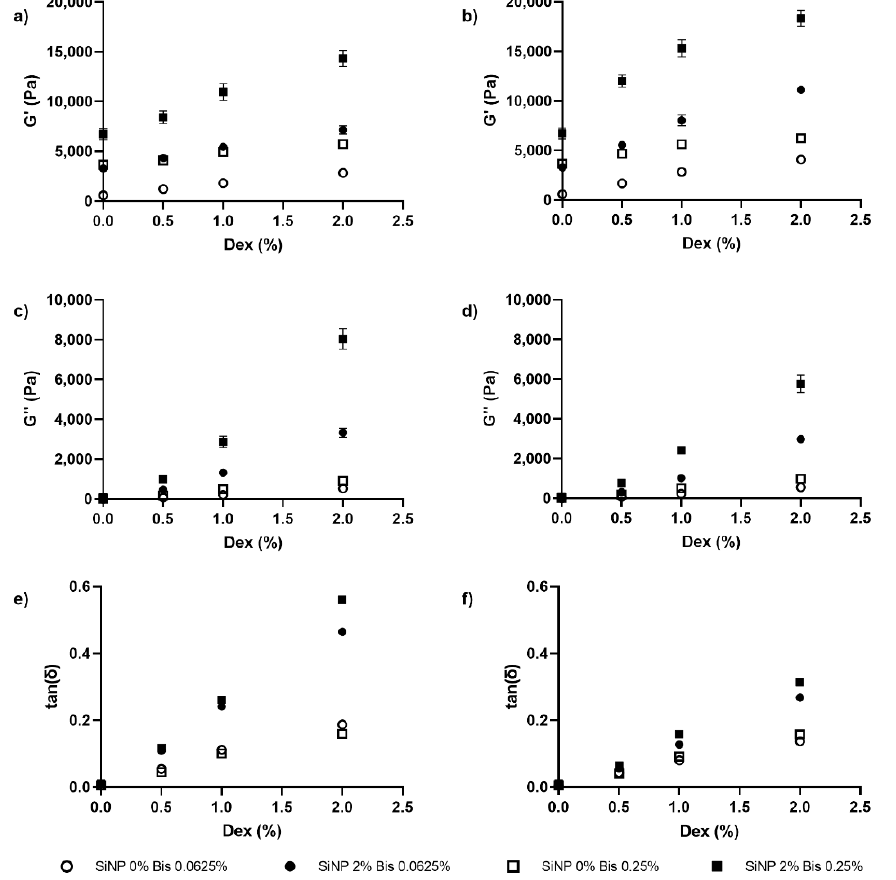
Figure 3. Mechanical properties of pAAm hydrogels as a function of dextran concentration prepared using different concentrations of silica nanoparticles and Bis crosslinker — ○ : 0% SiNP/0.0625% Bis, ●: 2% SiNP/0.0625% Bis, □: 0% SiNP/0.25% Bis, and ■ : 2% SiNP/0.25% Bis, and different molecular weights of Dex—elastic moduli (G’): ( a ) 100 kDa and ( b ) 500 kDa Dex; viscous moduli (G”): ( c ) 100 kDa and ( d ) 500 kDa Dex; and loss tangent (tan( δ )): ( e ) 100 kDa and ( f ) 500 kDa Dex. N = 3 for each hydrogel preparation.